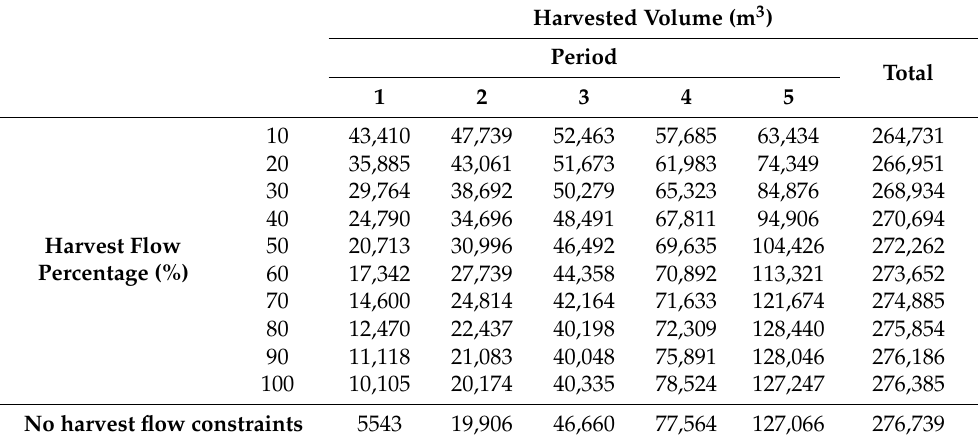
Table 1. The periodic and total harvested volumes for different harvest flow percentages obtained using the DET model for 50% protection level in the first planning period (PP).